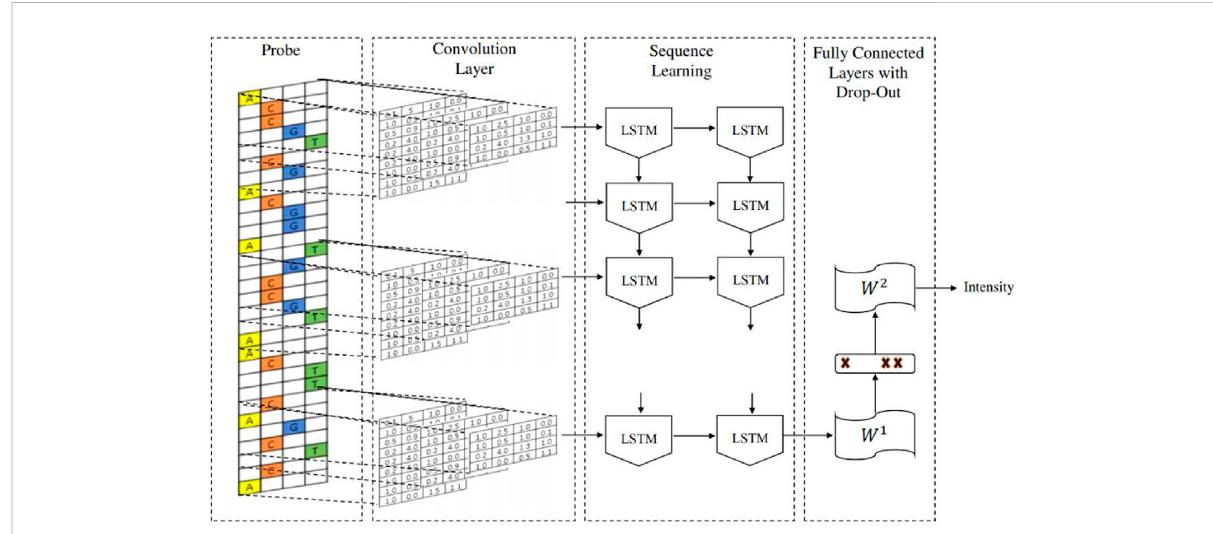
FIGURE 2 The architecture of the CNN DeeperBind